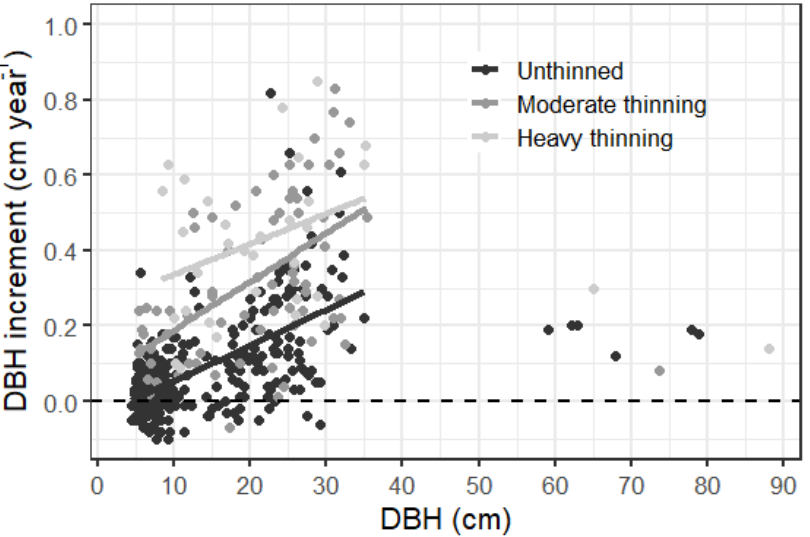
Figure A5. DBH increment (2009–2019) versus DBH of repeatedly measured trees (see Figure 4) grouped by the three stands. We show trend lines for trees with <40 cm DBH.